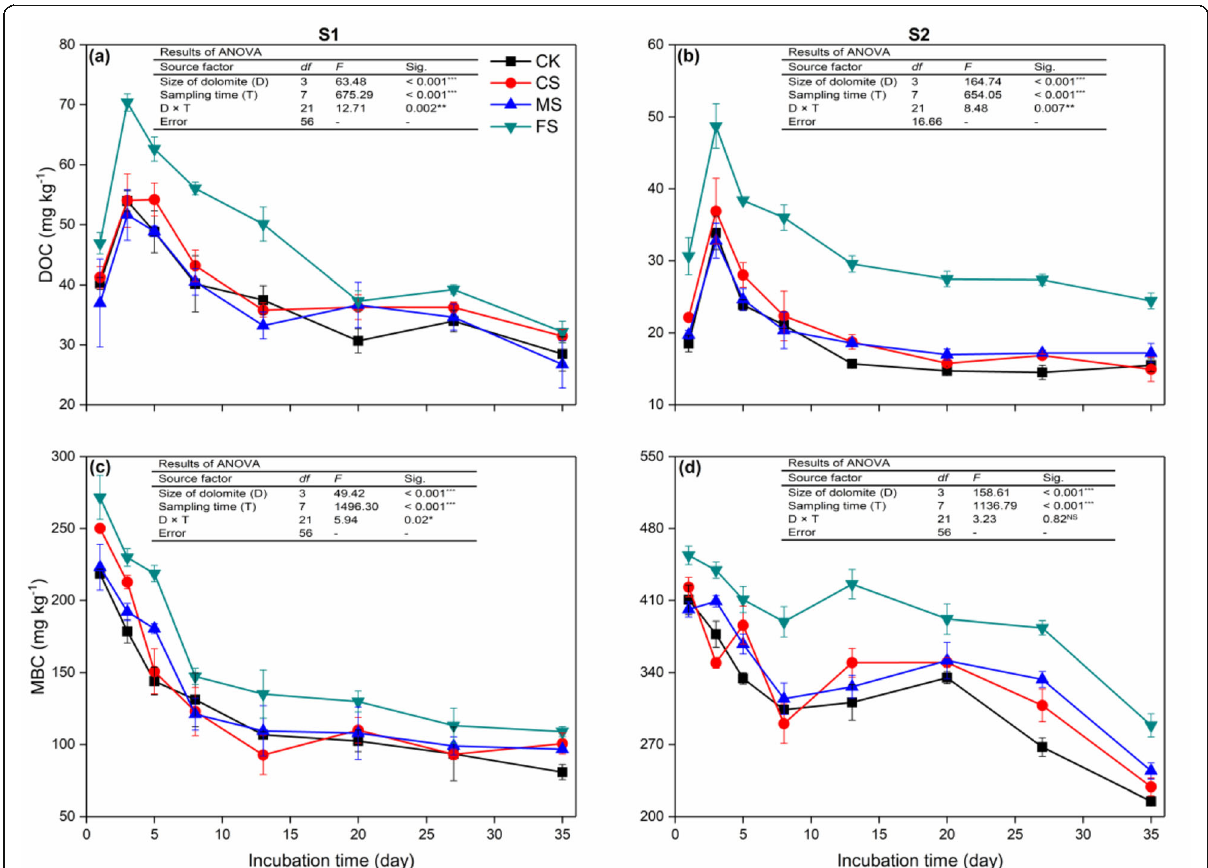
Fig. 2 Dynamics of soil dissolved organic carbon (DOC) and microbial biomass carbon (MBC) in S1 ( a , c ) and S2 ( b , d ) as affected by different sized dolomite application. Error bars represent standard deviation of the mean values ( n = 3). *** P < 0.001, ** P < 0.01, * P < 0.05. NS, no significance. See Fig. 1 for abbreviations of dolomite treatments and statistic